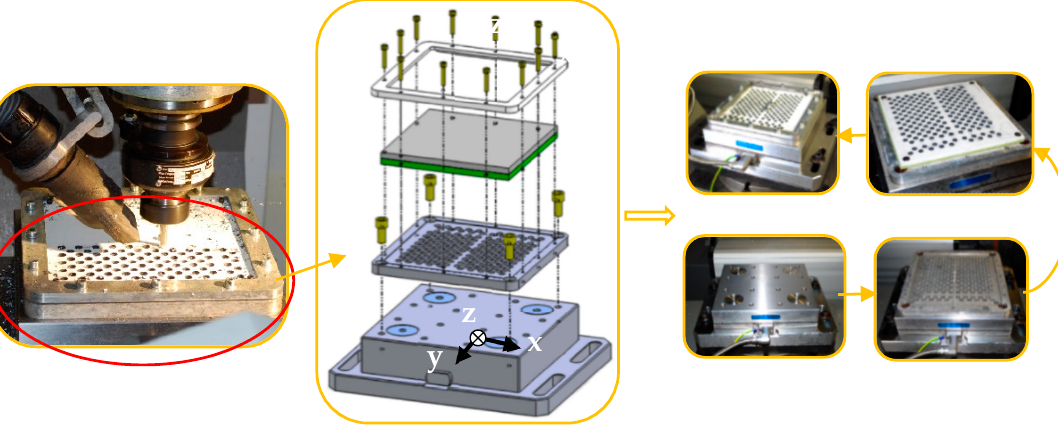
Figure 2. Dynamometric table and workpiece clamping system, showing the backplate support.